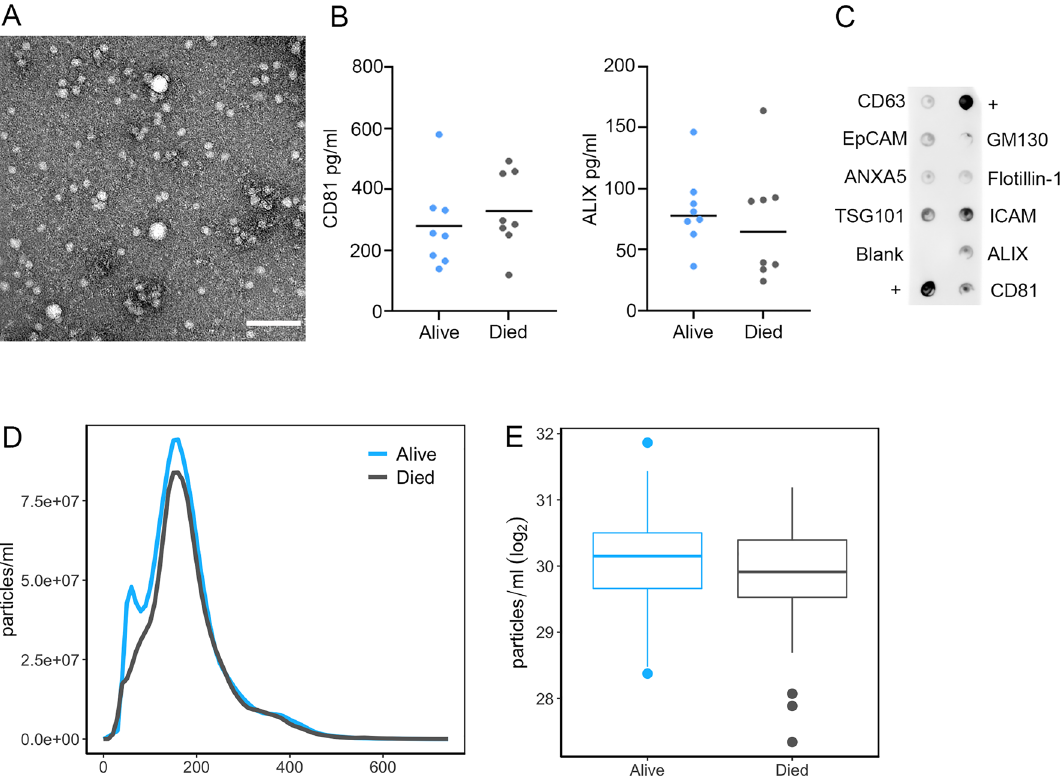
Figure 1. EV characteristics of mortality cohort. ( A ) EV morphology and size were visualized using electron microscopy (scale bar = 200 nm). ( B ) Plasma EVs from alive (n = 8) and individuals who had died (n = 8) within 5 years of sample collection were lysed and the EV markers CD81 and ALIX using quantified using ELISA assays. Individual data points are shown, and the bar represents the mean. There were no significant differences in CD81 and ALIX EV levels between alive and deceased individuals using Student’s t-test. ( C ) EV markers in plasma EVs were assessed using an Exo-Check™ Exosome Antibody Array. ( D,E ) Plasma EVs were isolated